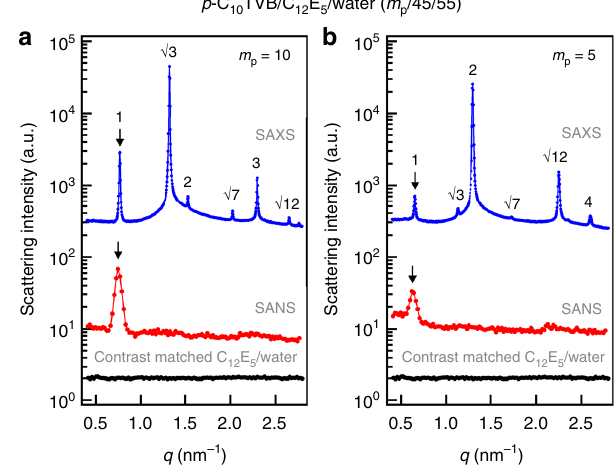
Fig. 5 Contrast matched SANS measurements. SANS intensities of the partially deuterated p -C 10 TVBs mixed with the contrast-matched C 12 E 5 /water at mixing ratios of a 10/45/55 and b 5/45/55. SAXS intensities of each sample are provided for comparison. All the data were measured at 6 °C. Scattering intensities are shifted vertically for visual clarity